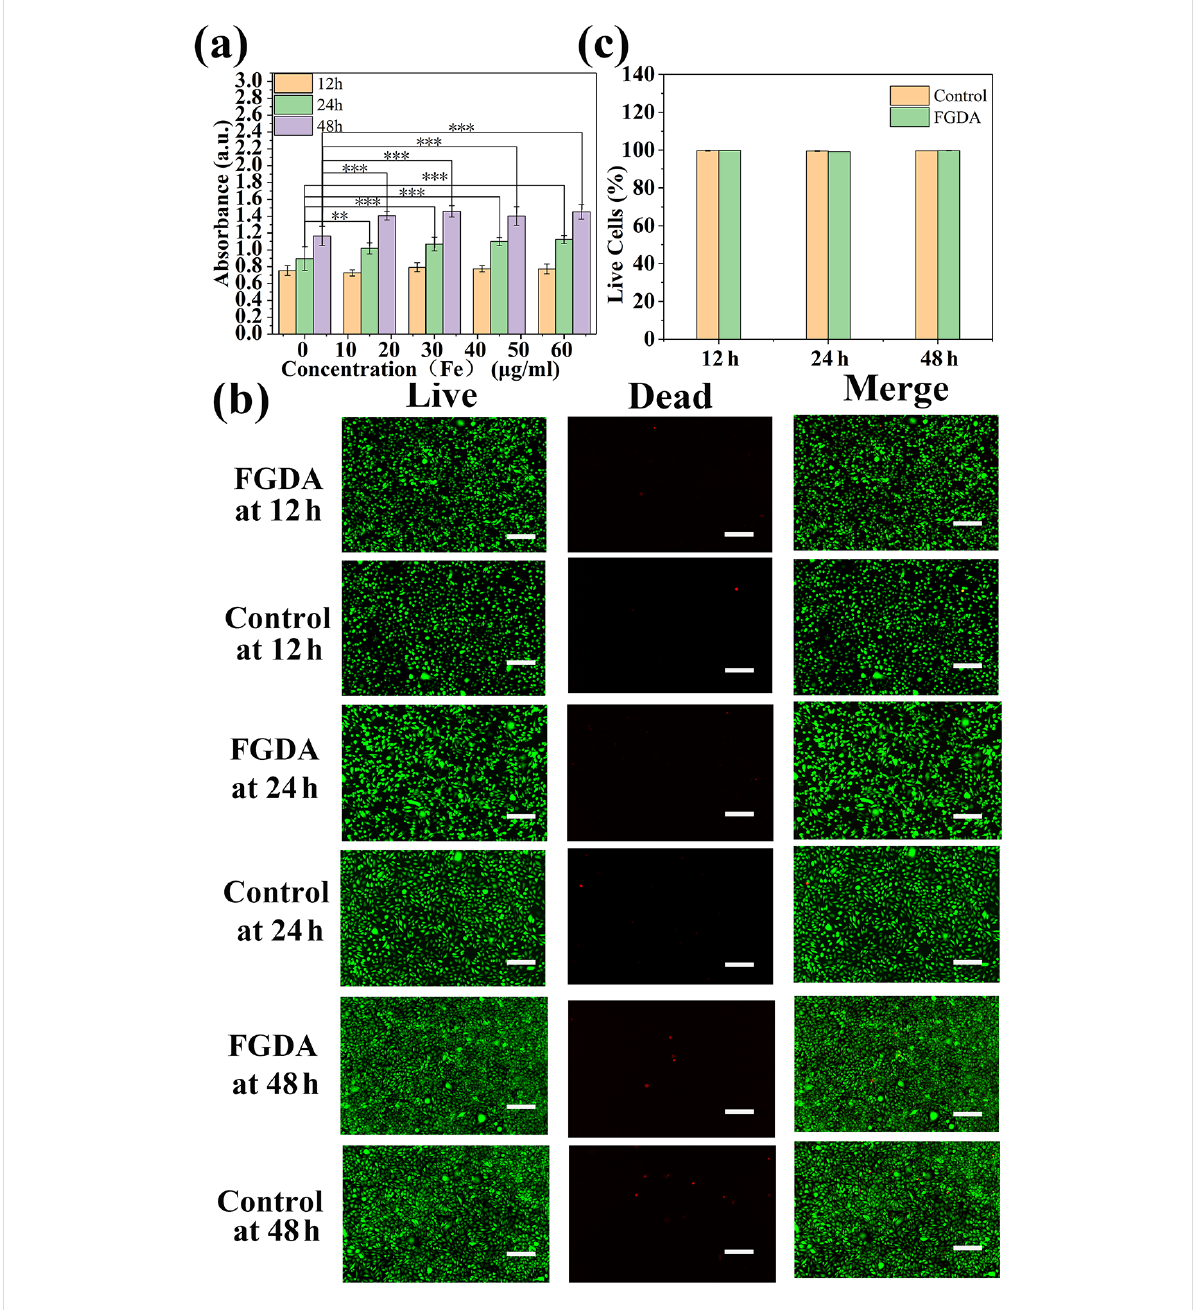
Figure 4: (a) CCK-8 cell viability test of L929 cells incubated with FGDA at different Fe concentrations for 12, 24, and 48 h. (b) Live–dead staining of control and FGDA-treated groups (Fe concentration: 60 μ g/mL) after 12, 24, and 48 h of incubation. (c) Quantification of live cells shown in (b). Scale bar: 100 μ m. ** and *** represent P < 0.01 and P < 0.001,